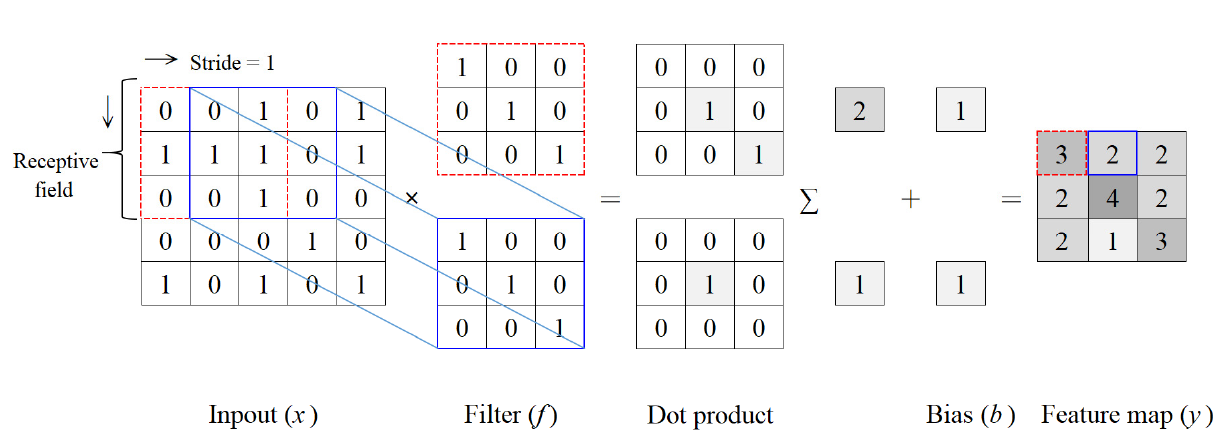
Figure 1. The calculation process for the features of the convolutional layer.